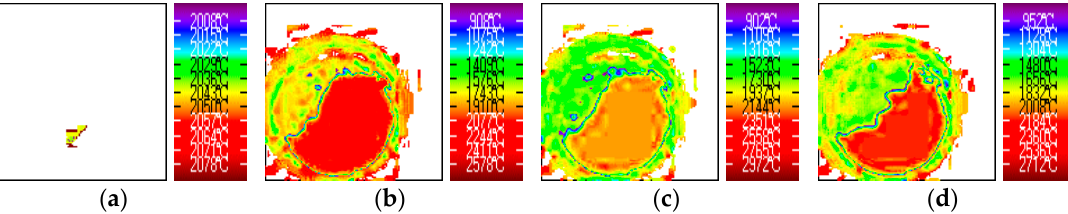
Figure 6. Calculated temperature field image of series 1 with CMS. ( a ) Ignition moment; ( b ) maximum pressure rise rate; ( c ) maximum heat release; ( d ) the highest pressure.